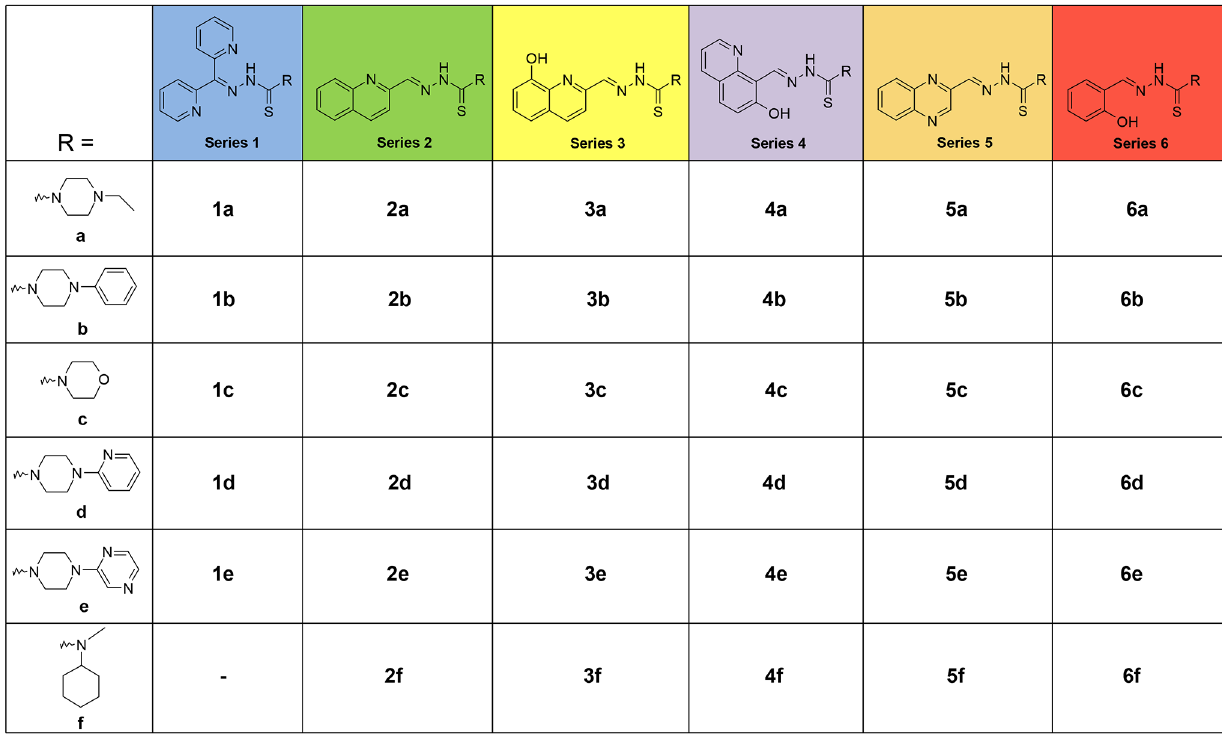
Figure 5. Chemical structures of the thiosemicarbazone chelators of series 1–6.